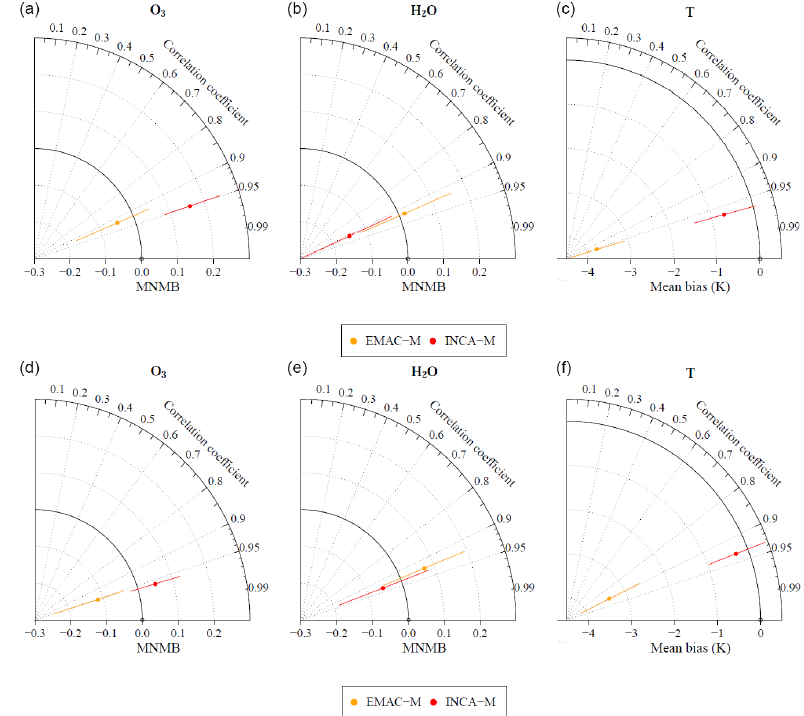
Figure A6. Same as Fig. 4 for winter (a–c) and spring (d–f) .